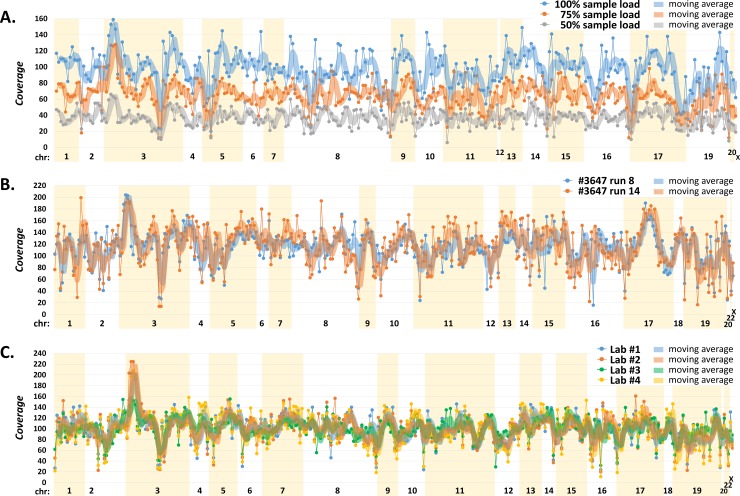
Analysis of intra-run (A), inter-run (B), and inter-laboratory (C) replicates. The panels show sequencing coverages (y-axis) of the identified variants arranged according to chromosomal localizations (x-axis). We used moving average curves (average of 3 values) to compare trends in coverages. Panel (A) describes the results of an analysis of three independently processed intra-run replicates from an identical DNA sample pooled in 33 ng (considered as 100%), 24.75 ng (75%), and 16.5 ng (50%), respectively. Panel (B) demonstrates variant coverages identified in two independent inter-run (run 8 and 14) replicates. All coverage values of sample #3647 in run 14 were corrected by a factor of 1.3880 to normalize coverages between samples (see S4 Table). Panel (C) shows coverages of variants identified in an inter-laboratory control sequenced in four laboratories (Lab) participating in panel validation (see S5 Table). The coverages of variants identified in Lab 2, 3, and 4 were normalized to the average coverage of Lab 1 for better comparisons of coverages.